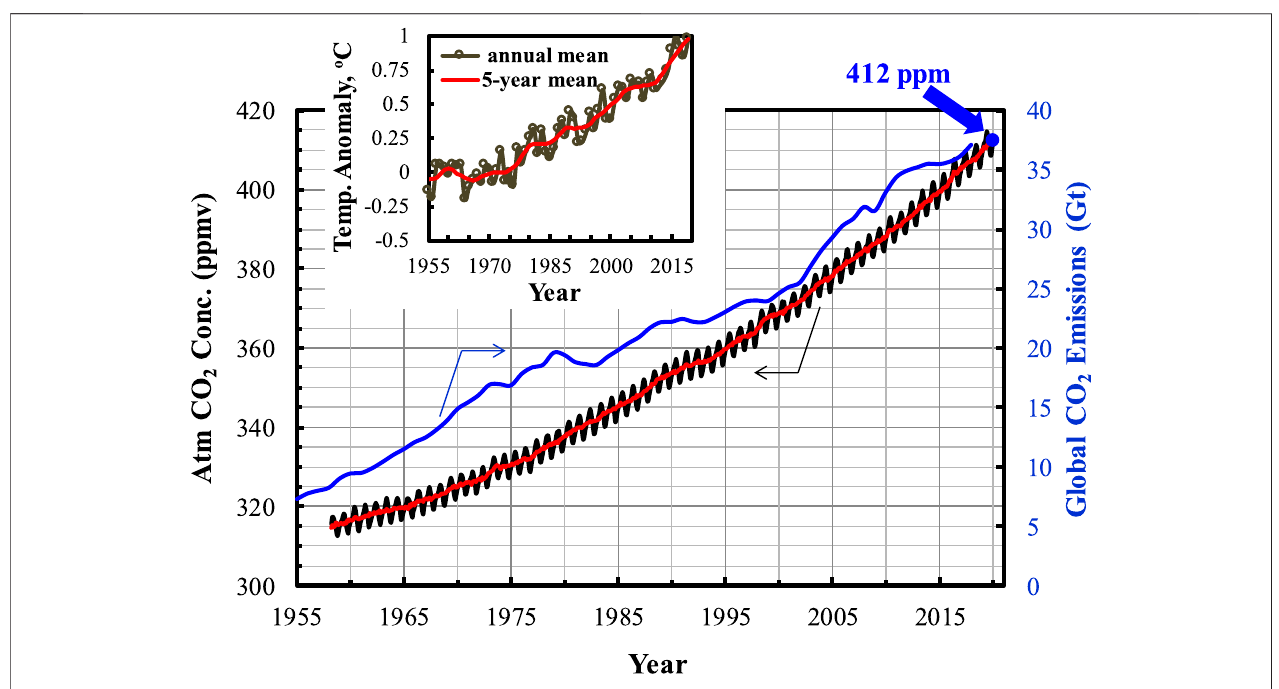
FIGURE 1 | Atmospheric CO 2 concentration during 1950 – 2019 (data sources: http://climate.nasa.gov/vital-signs/carbon-dioxide/).